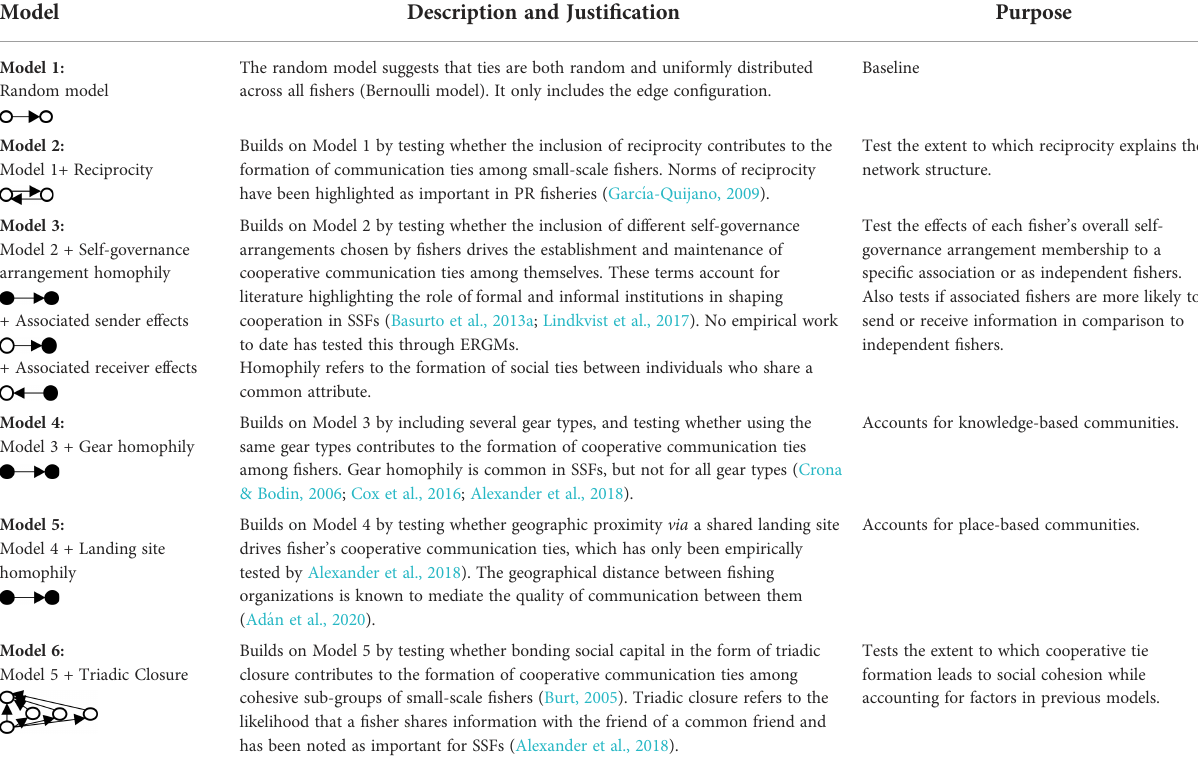
TABLE 1 Descriptions of the sequential exponential random graph models (ERGM) developed for the information-sharing network among commercial fi shers, expanding on the hypothesis explored by Alexander et al., 2018.